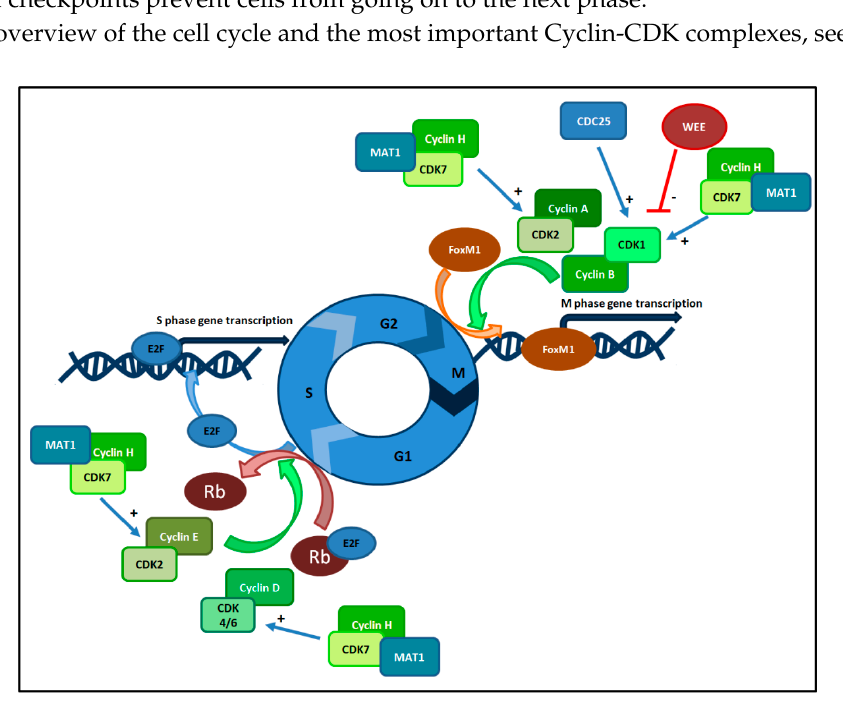
Figure 1. Cell Cycle and CDK complexes.